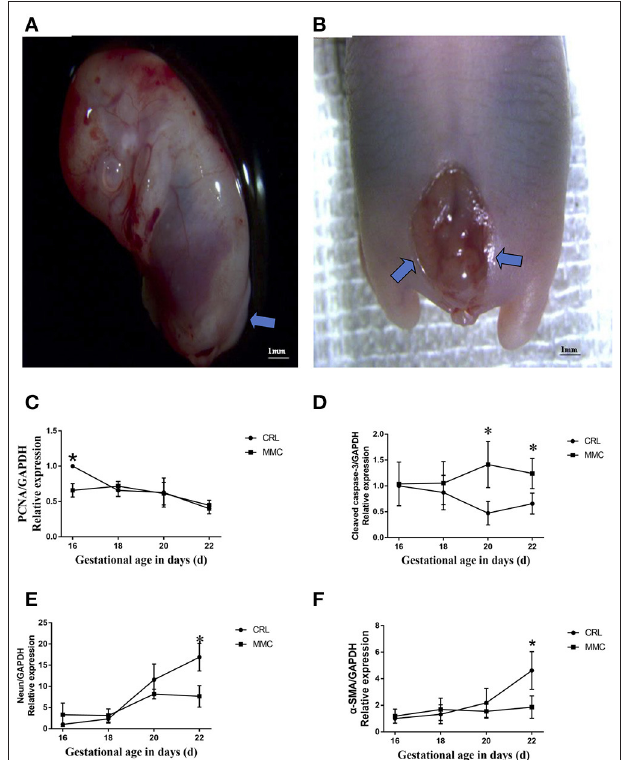
FIGURE 1 | Representative photographs of spinal cord in fetuses with lumbosacral myelomeningocele. (A) E16, neural tube closure failed, nerve tissue is exposed dorsally and protrudes above the skin level. (B) E20, the myelomeningocele exhibits abrasion and hemorrhage, a thin fibrous membrane covers the defect. (C–F) The mRNA expression levels of PCNA (C) , cleaved caspase-3 (D) , NeuN (E) , and α - SMA (F) in the MMC and CRL groups changed with the development of the embryos, n = 5, * P < 0.05. Data are expressed as means ± STDs. MMC, myelomeningocele; CRL, control; STD, standard deviation; PCNA, proliferating cell nuclear antigen; α -SMA, α -smooth muscle actin; NeuN, neuron-specific nuclear-binding